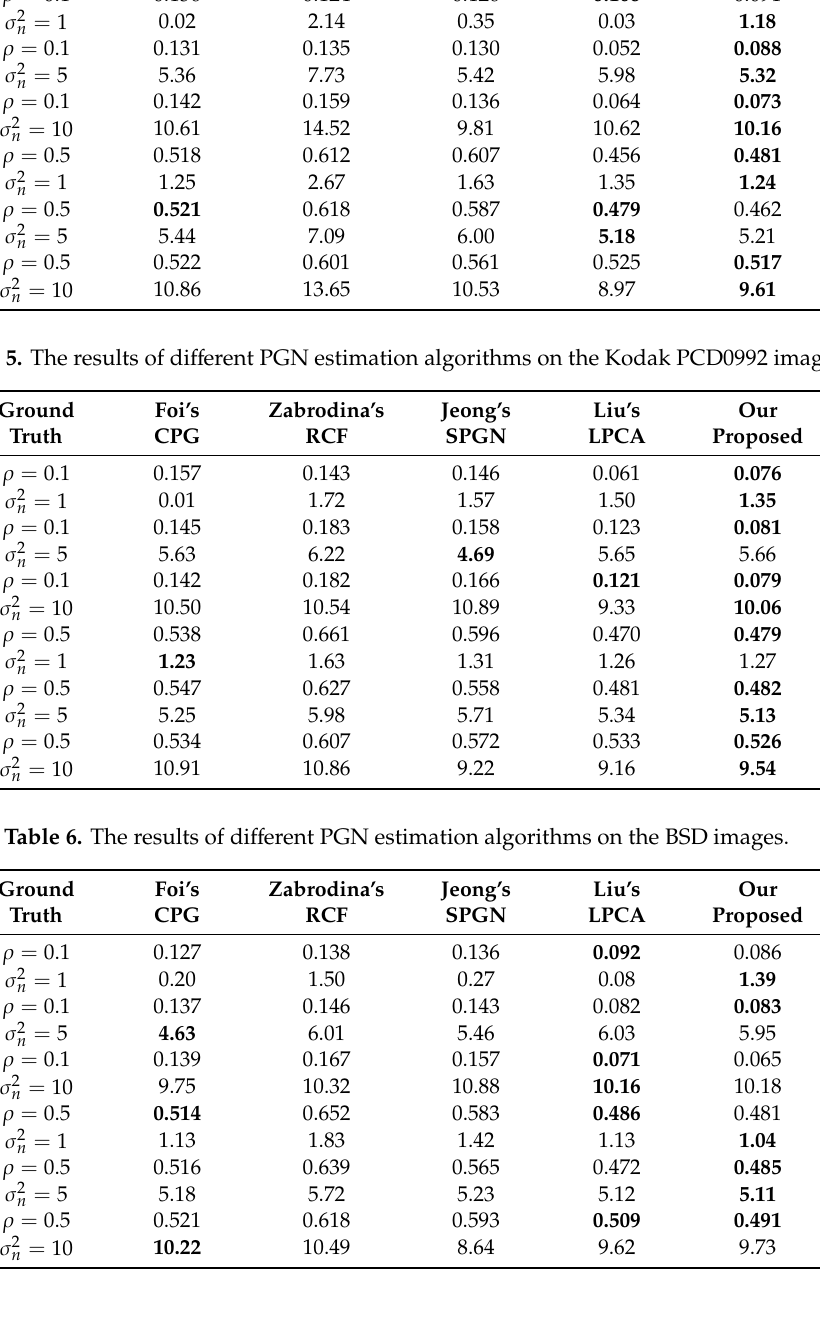
Table 4. The results of di ff erent PGN estimation algorithms on the CSTI images. Ground